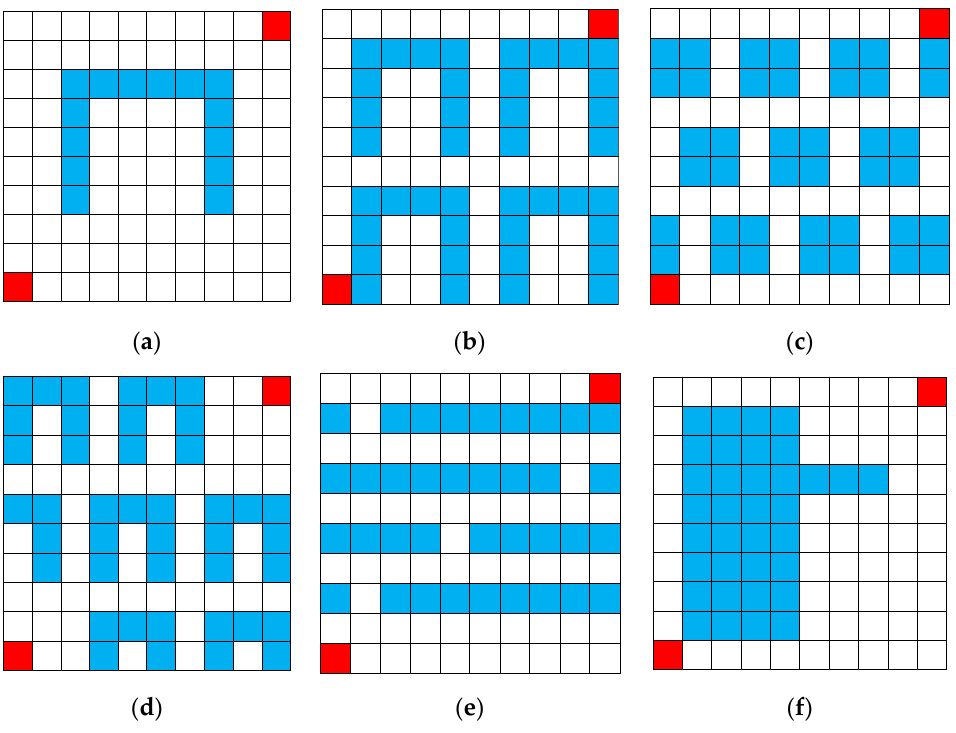
Figure 9. The experimental configuration of the 10 × 10 cells: ( a ) 10_1n; (b) 10_4n; ( c ) 10_11s; ( d ) 10_7n; ( e ) 10_4ch; and, ( f ) 10_1o.